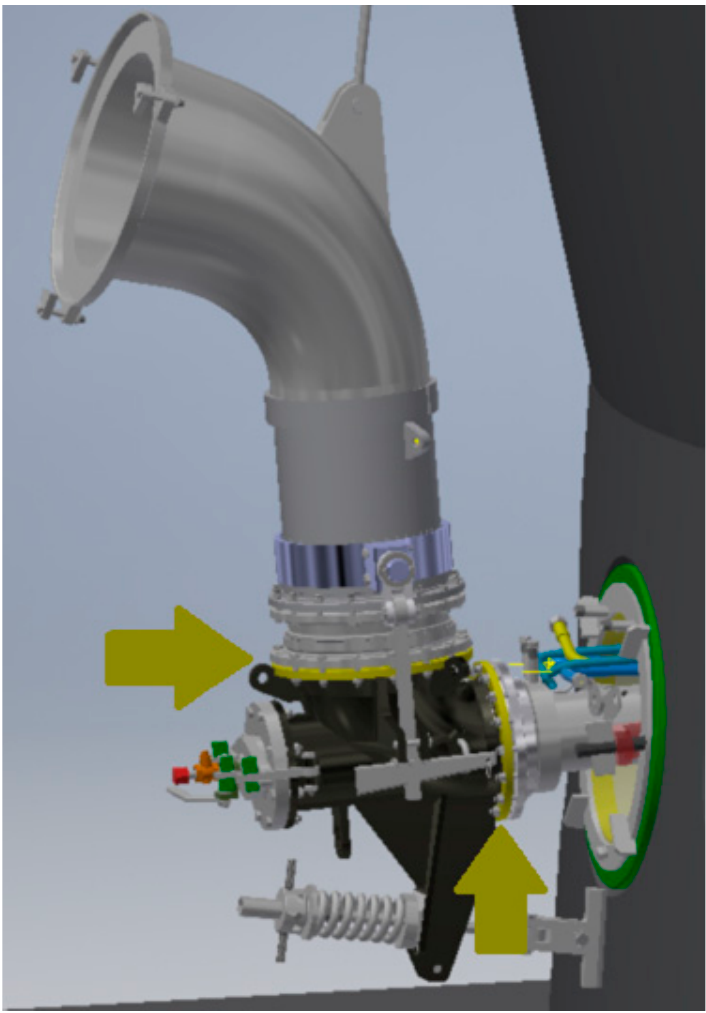
Figure 2. Tuyere tool BF (black shows a suspended (movable) knee, arrows show water-cooled